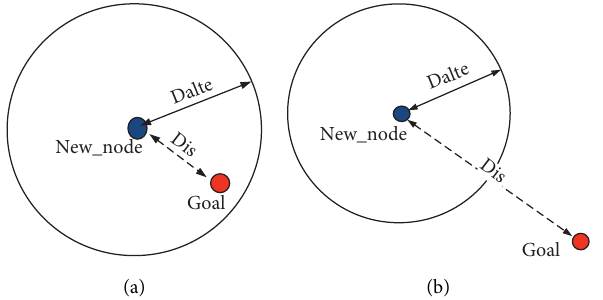
Figure 5: Schematic diagram of the different search targets. (a) The original algorithm search target; (b) the improved algorithm search target.